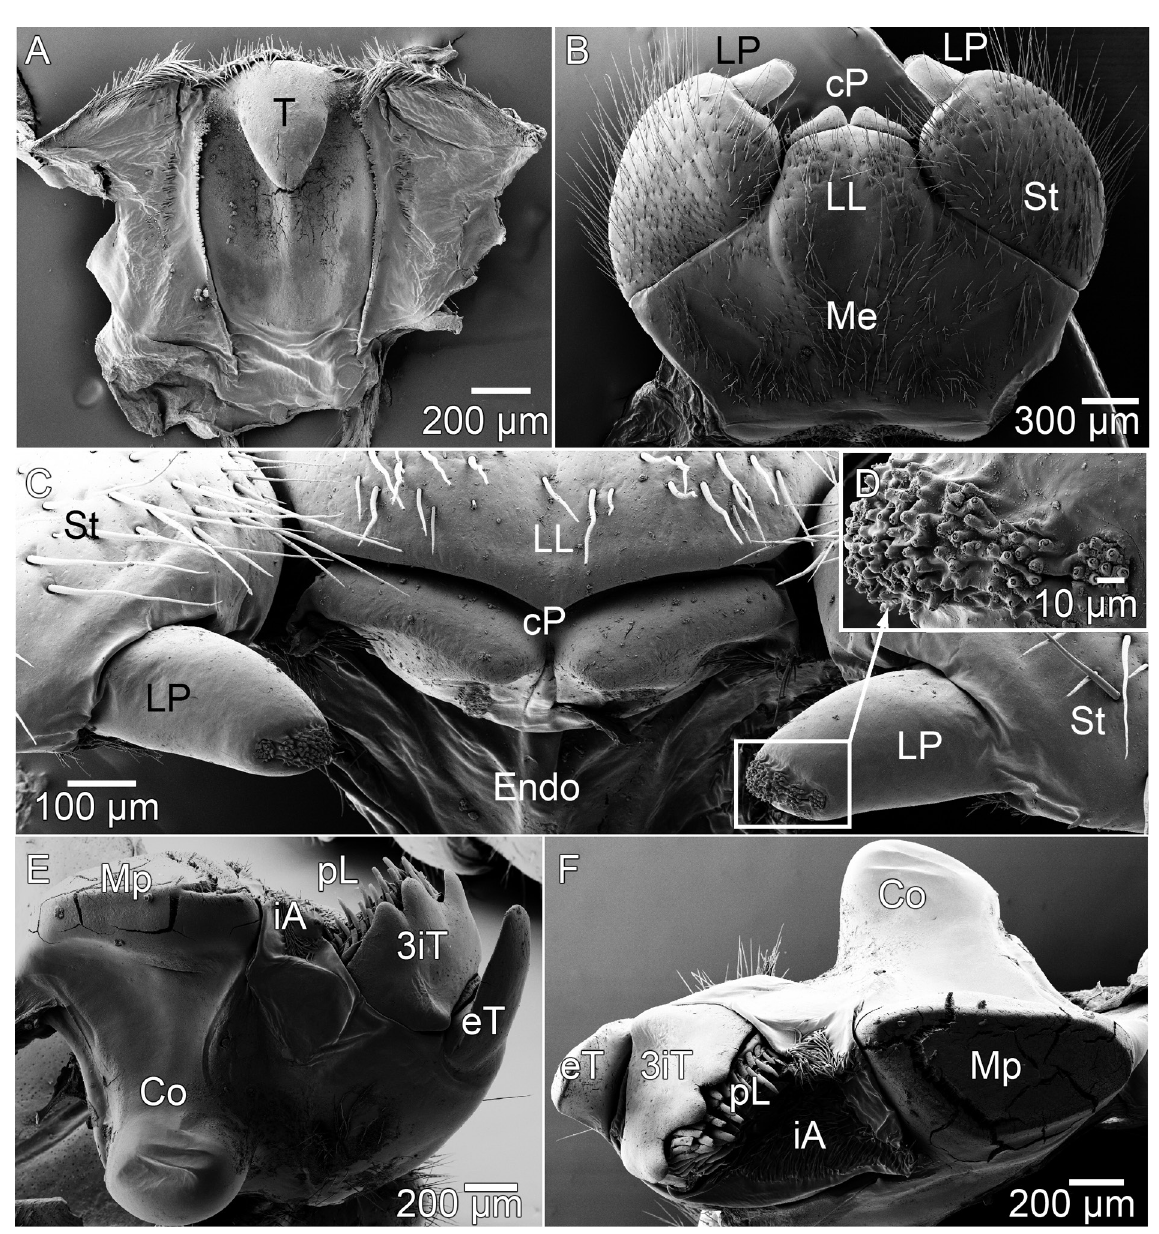
Fig. 8. Zephronia viridisoma Rosenmejer & Wesener sp. nov., paratype, ♂ (ZFMK MYR8786), mouthparts, scanning electron micrographs. A . Epipharynx, ventral view. B . Gnathochilarium, underside. C . Gnathochilarium frontal view at lateral palps and central pads. D . Detail of sensory cones at lateral palps. E . Right mandible, dorsal view. F . Right mandible, mesal view. Abbreviations: 3iT = 3-combed inner tooth; Co = condylus; cP = central pads; Endo = endochilarium; eT = external tooth; iA = inner area; LL = lamellae linguales; LP = lateral palpi; Me = mentum; Mp = molar plate; pL = pectinate lamellae; St = stipes; T = tooth of